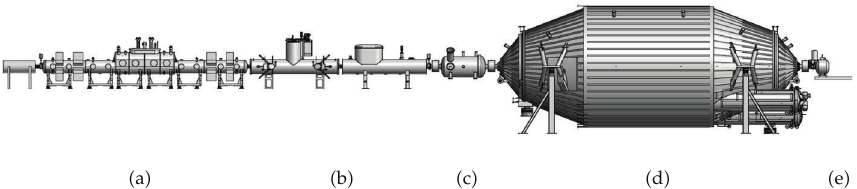
Figure 15: Schematic view of the complete 70m long KATRIN setup. (a) Windowless Gaseous Tritium Source (WGTS). (b) Transport section consisting of a differential (DPS2-F) and a cryogenic (CPS) pumping section. (c) Prespectrometer: prefilter of 𝛽 -spectrum. (d)